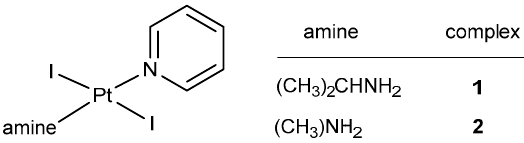
Figure 1. Structure and numbering of the complexes studied in this manuscript.